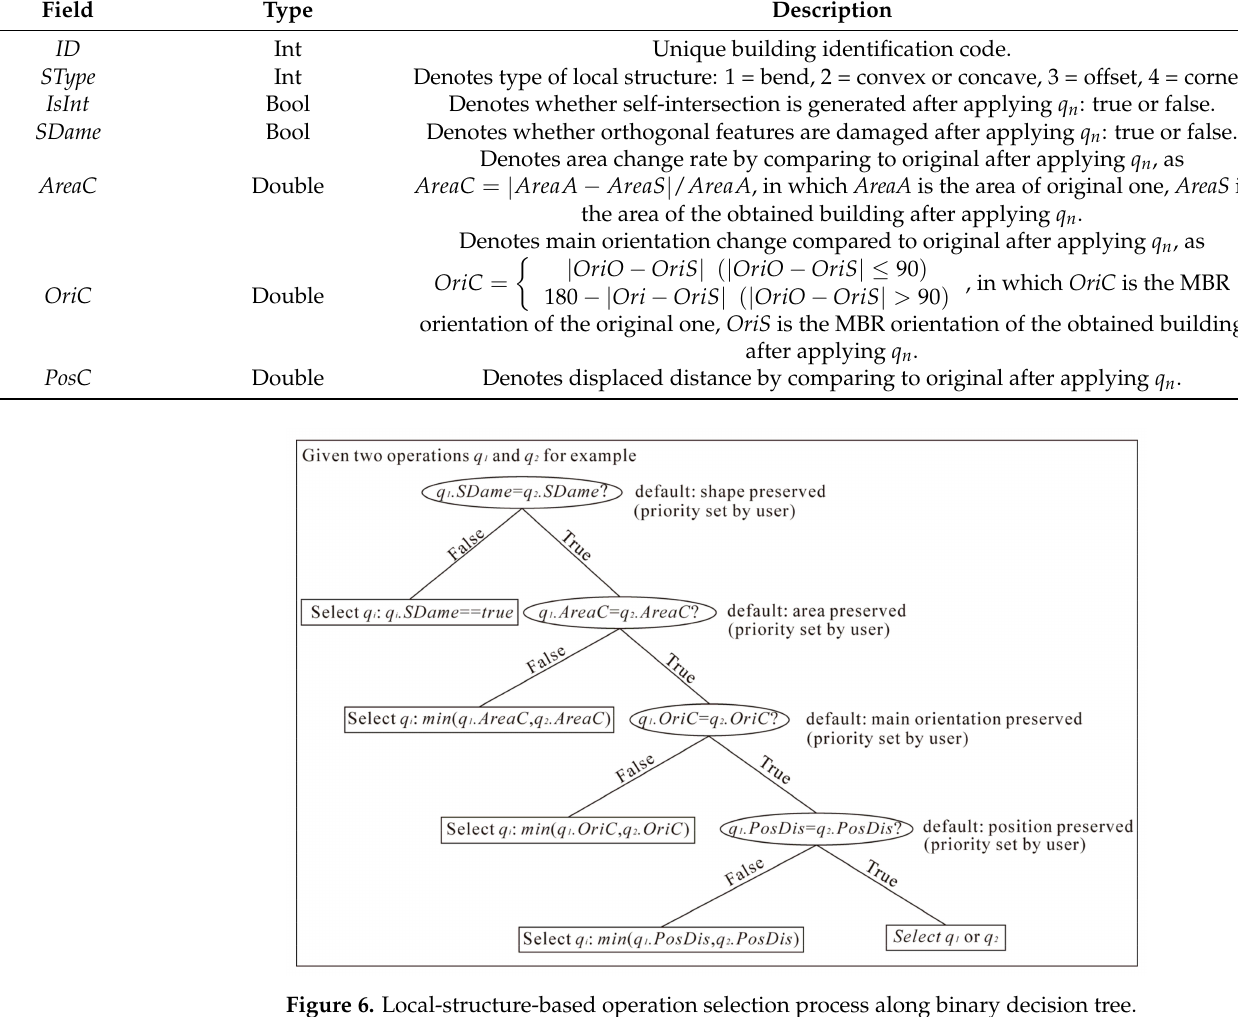
Figure 6. Local-structure-based operation selection process along binary decision